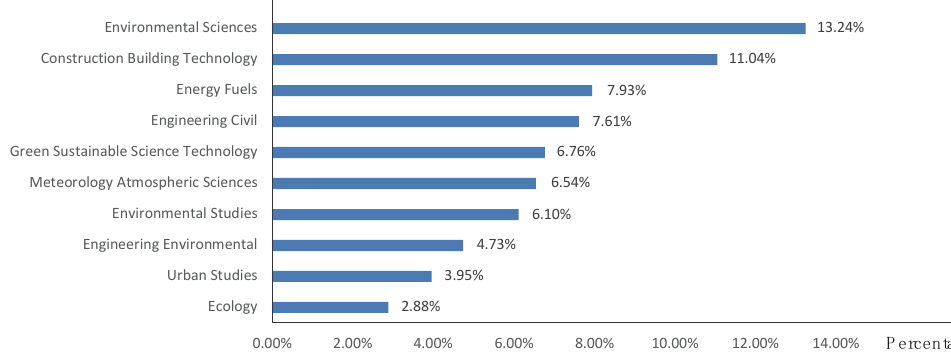
Figure 2. Percentage of urban microclimate papers by discipline (top